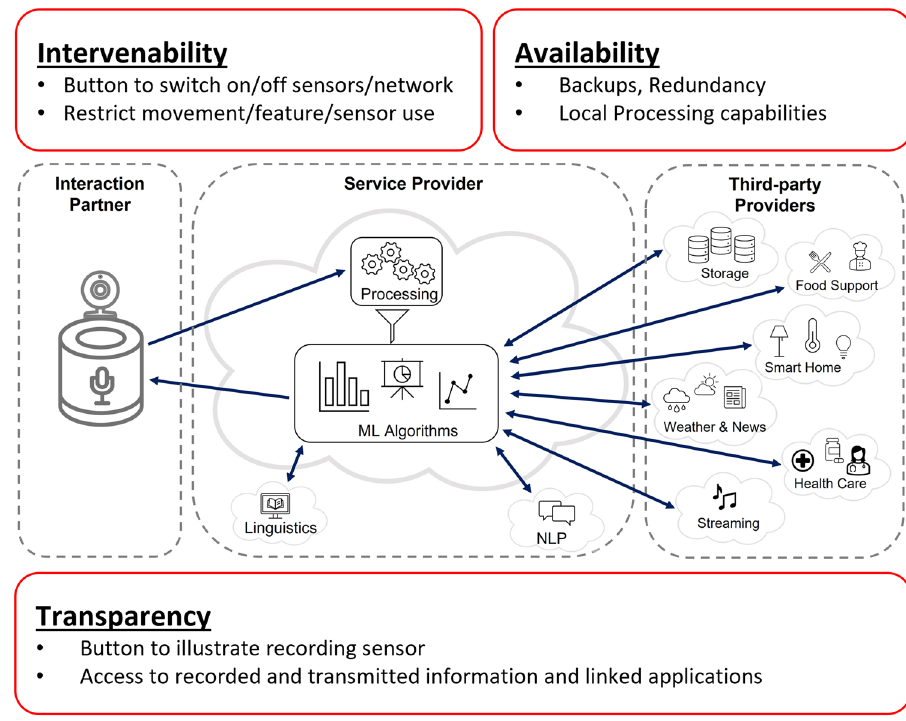
Figure 4: Mitigation strategies for respective interrelations in the context of health care supervision or work